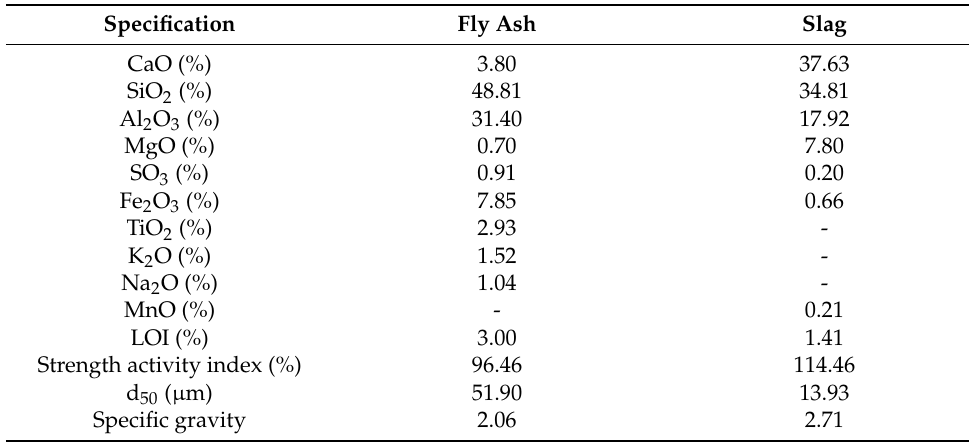
Figure 1. Particle size distribution of precursors. Table 1. Specifications of precursors.